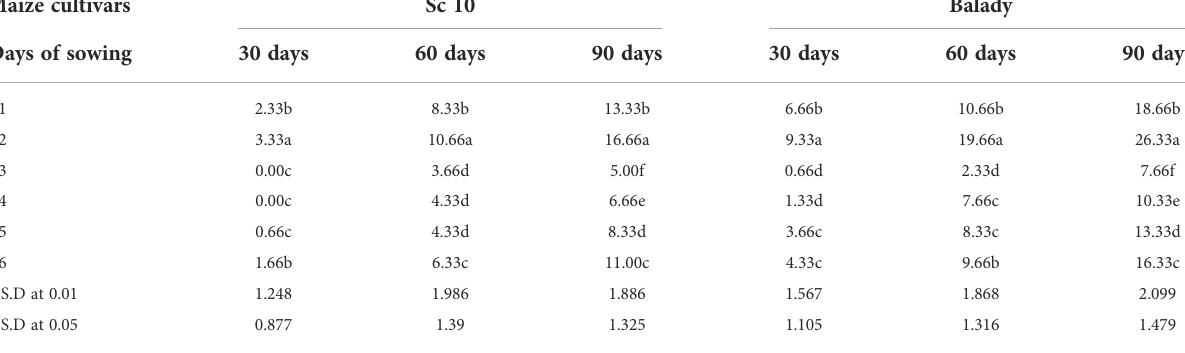
TABLE 6 Fusarium verticillioides frequency % from stalk under different soil treatments at different times after sowing during the 2020 growing season. Maize cultivars